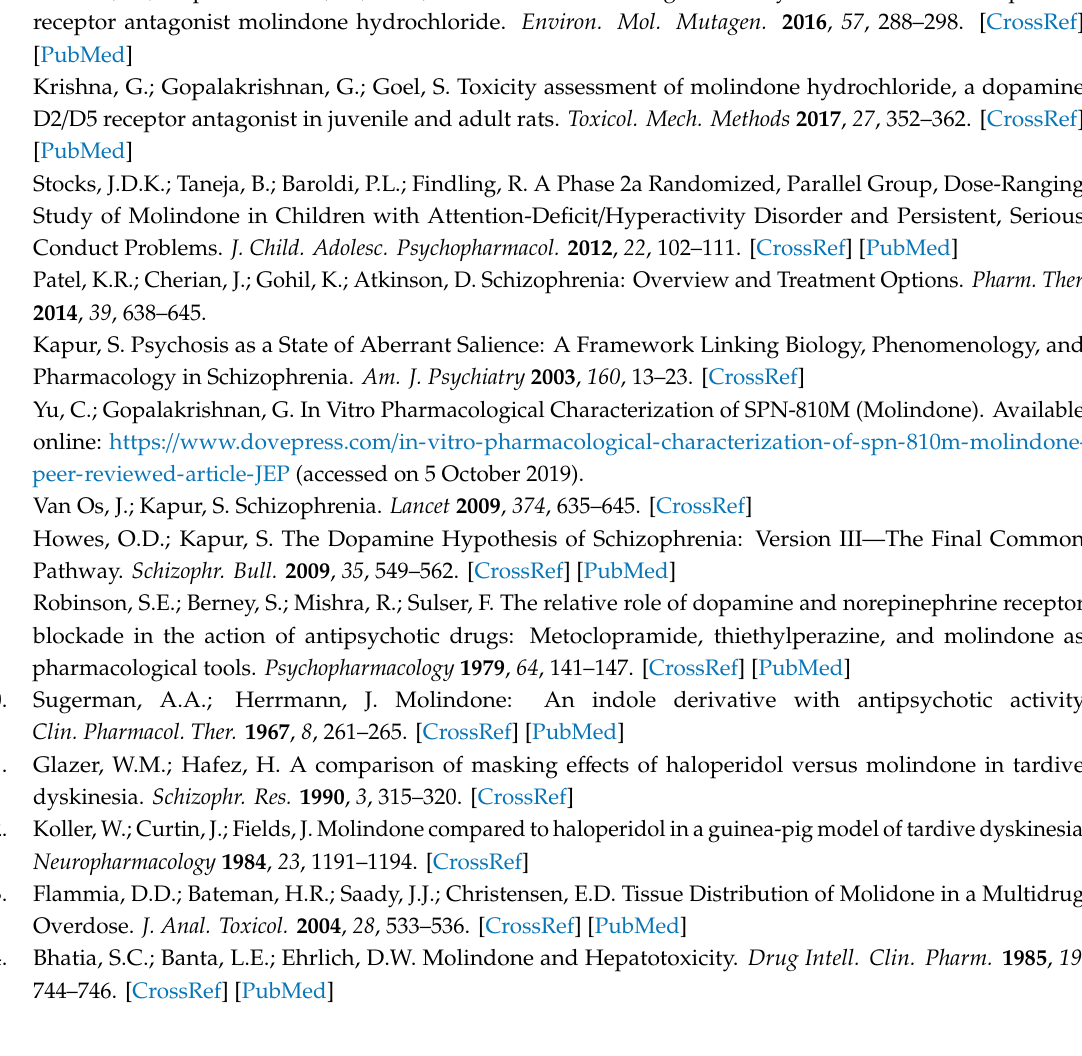
Supplementary Materials: The following are available online: Figure S1: MS / MS spectrum and fragmentation pathway of molindone, Figure S2: MS / MS spectrum and fragmentation pathway of M1, Figure S3: MS / MS spectrum and fragmentation pathway of M2, Figure S4: MS / MS spectrum and fragmentation pathway of M3, Figure S5: MS / MS spectrum and fragmentation pathway of M4, Figure S6: MS / MS spectrum and fragmentation pathway of M5, Figure S7: MS / MS spectrum and fragmentation pathway of